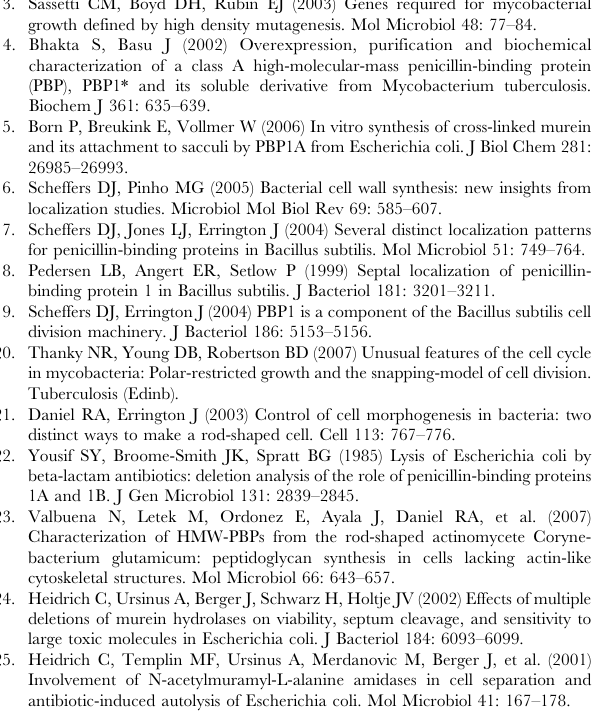
Figure S2 PBP1 depletion strain escape from regulation (A) Growth of the PBP1 depletion strain was analyzed by optical density in the presence and absence of the inducer, anhydrote- tracycline (ATC). (B) ponA1 expression was analyzed by RT-PCR in PBP1 depletion strains grown in the presence of inducer (50 ng/ ml ATC) and in three independent cultures grown without inducer (no ATC). The no ATC cultures began to grow at late time points ( , 50 hours). All four strains were taken at mid exponential phase for PBP1 transcript analysis and normalized by sigA